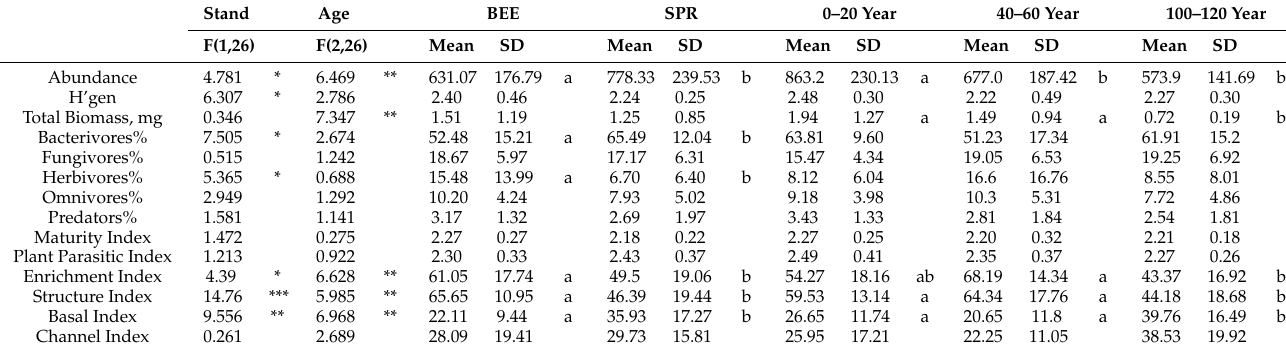
Table 5. Main effect ANOVA results for factors ‘stand’ (BEE—European beech Fagus sylvatica L.; SPR—Norway spruce Picea abies (L.) H. Karst.) and ‘age’ (0–20-, 40–60-, and 100–120-year-old forests). Mean and standard deviation (SD) of nematode abundance, genera diversity index, H’gen, abundance of nematodes in trophic groups—ecological and functional indices. Soil sampling in 2019 in Pol’ana Mts., Slovak